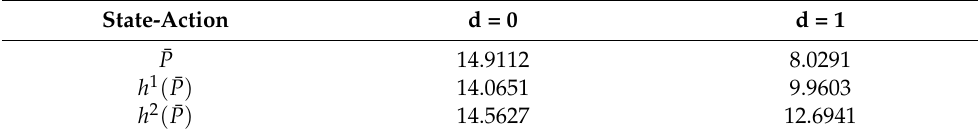
Table 3. Convergent Q -table based on Q -learning from the perspective of attacker.